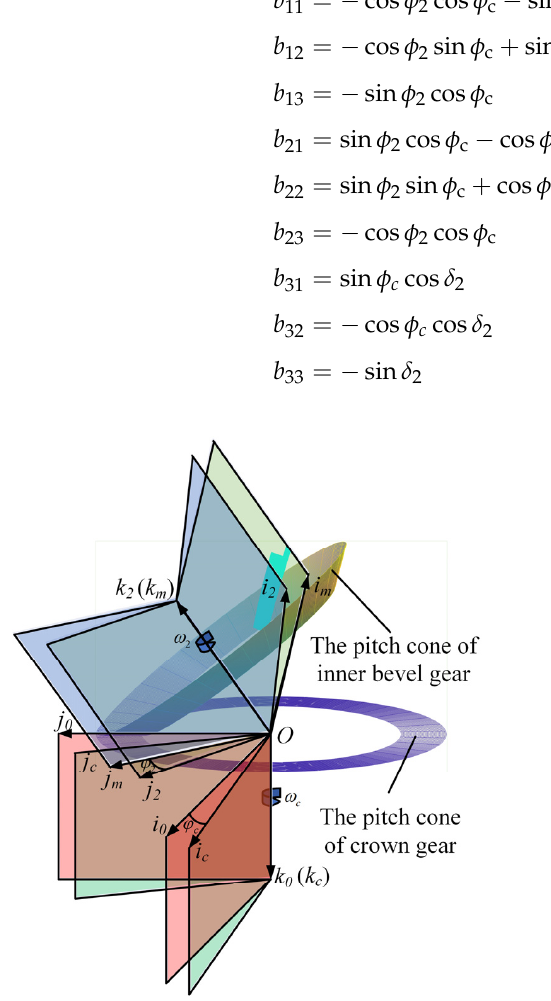
Figure 5. Meshing coordinate system for crown gear and internal spiral bevel gear. tooth alignment curve. The double-arc tooth profile scanned along the actual tooth align- ment curve to form the tooth profile of the crown gear. The E and R change, and their change law is related to the tooth alignment curve equation. The β d is the included angle between the tangent passing through any point and the connecting line between the point and the origin, and the central tooth alignment curve meets when β d = β . The equidistant curves of the left and right boundary tooth profiles meet at β d = β ± ∆ ϕ j